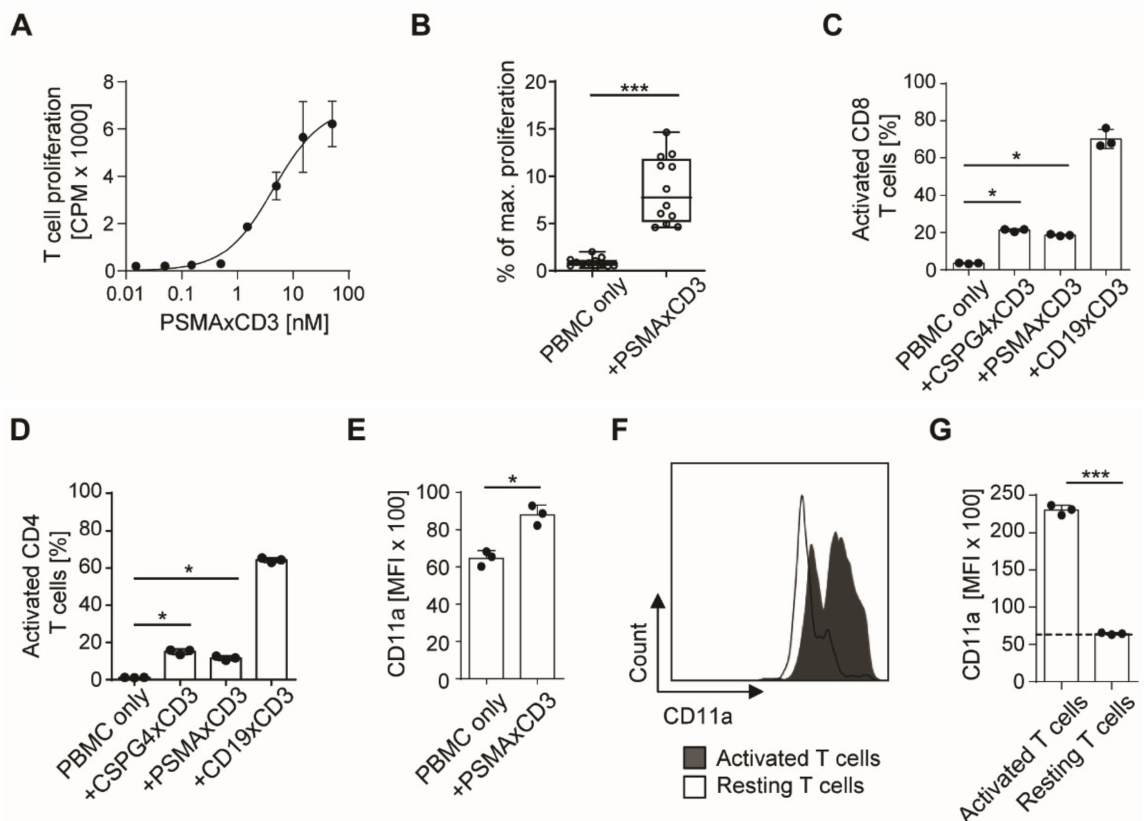
Figure 1. Off-target T cell activation by bsAbs in the absence of target cells. ( A ) Off-target T cell proliferation was measured in a 3 day 3H-thymidine incorporation assay with a PSMAxCD3 bsAb and 100,000 PBMC. Exemplary results from experiments using PBMC from 5 different donors (mean ± SD of triplicates). ( B ) T cell proliferation in a thymidine assay with PBMCs from 12 donors using PSMAxCD3 bsAb at 5 nM (boxplots with min/max whiskers, unpaired t -test). Standardization to maximum proliferation (set to 100%) as observed with PBMC + phytohemagglutinin was performed. ( C , D ) Flow cytometric analysis of T cell activation (CD69 expression) on CD8+ and CD4+ T cells after 3-day stimulation of 100,000 PBMC with different bsAb at 5 nM ( n = 3, mean ± SD, unpaired t -test). ( E ) Flow cytometric analysis of CD11a expression on CD8+ T cells upon 3 day off-target stimulation with PSMAxCD3 bsAb at 5 nM ( n = 3, mean ± SD, unpaired t -test). ( F , G ) Median CD11a fluorescence intensity on off-target activated CD8+CD69+ T cells and resting CD8+CD69- T cells after 3 days stimulation with a PSMAxCD3 antibody as measured by flow cytometry ( n = 3, mean ± SD, unpaired t -test). Open peaks indicate resting T cells, shaded peaks show activated CD69+ T cells. Dotted line indicates expression level on unstimulated PBMC. * p < 0.05, *** p <